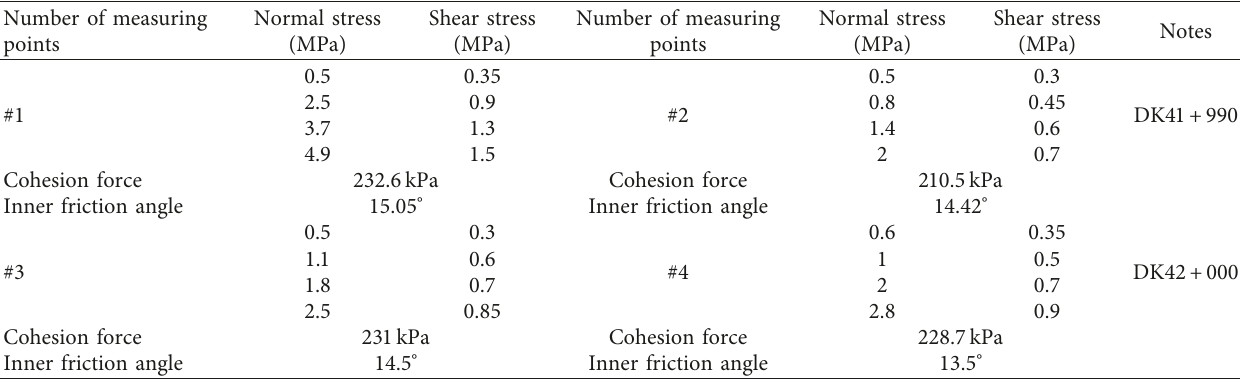
Table 2: The results of borehole shear